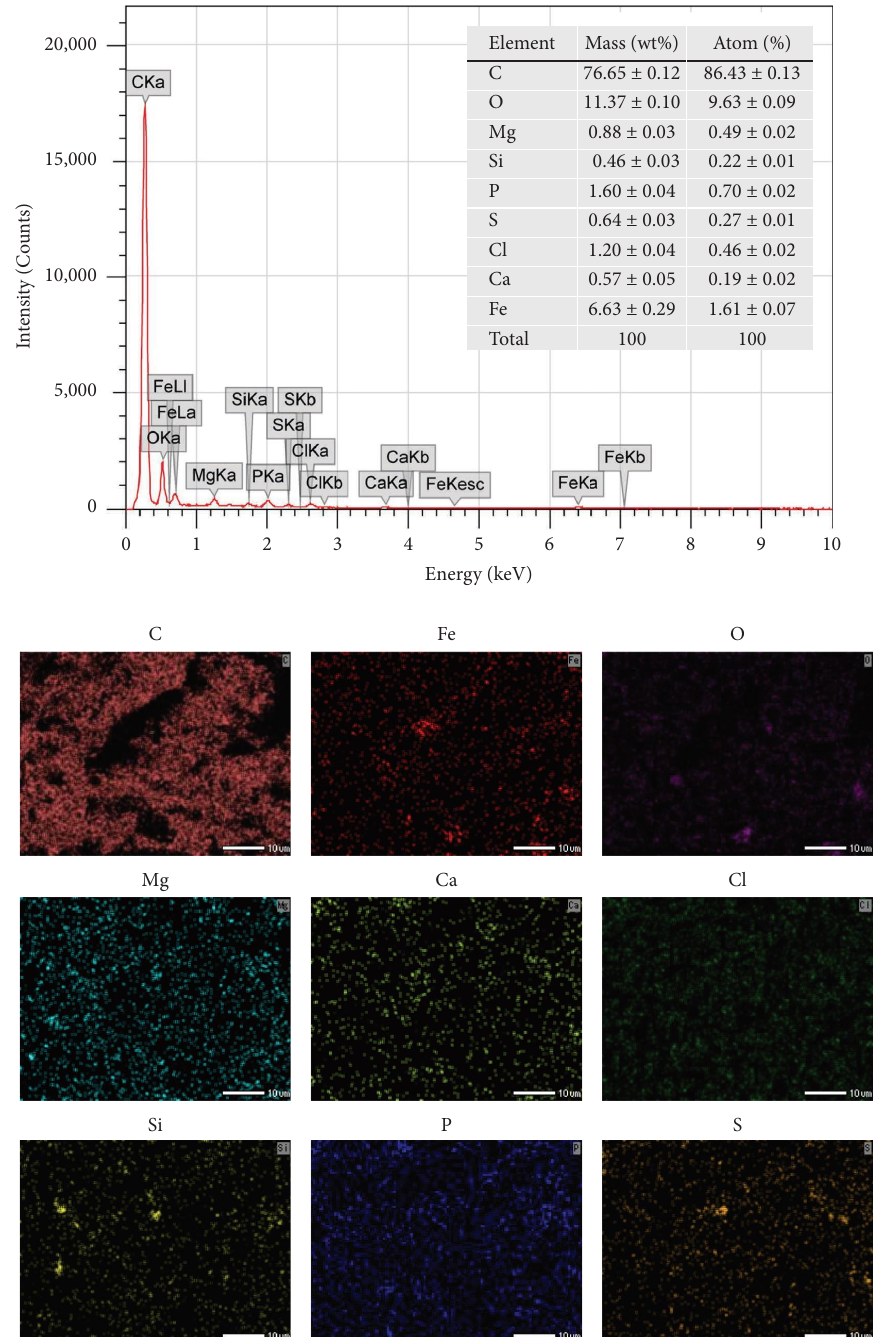
Figure 8: EDX spectroscopy and elemental mapping of MPC-R0.1–2.0 h.